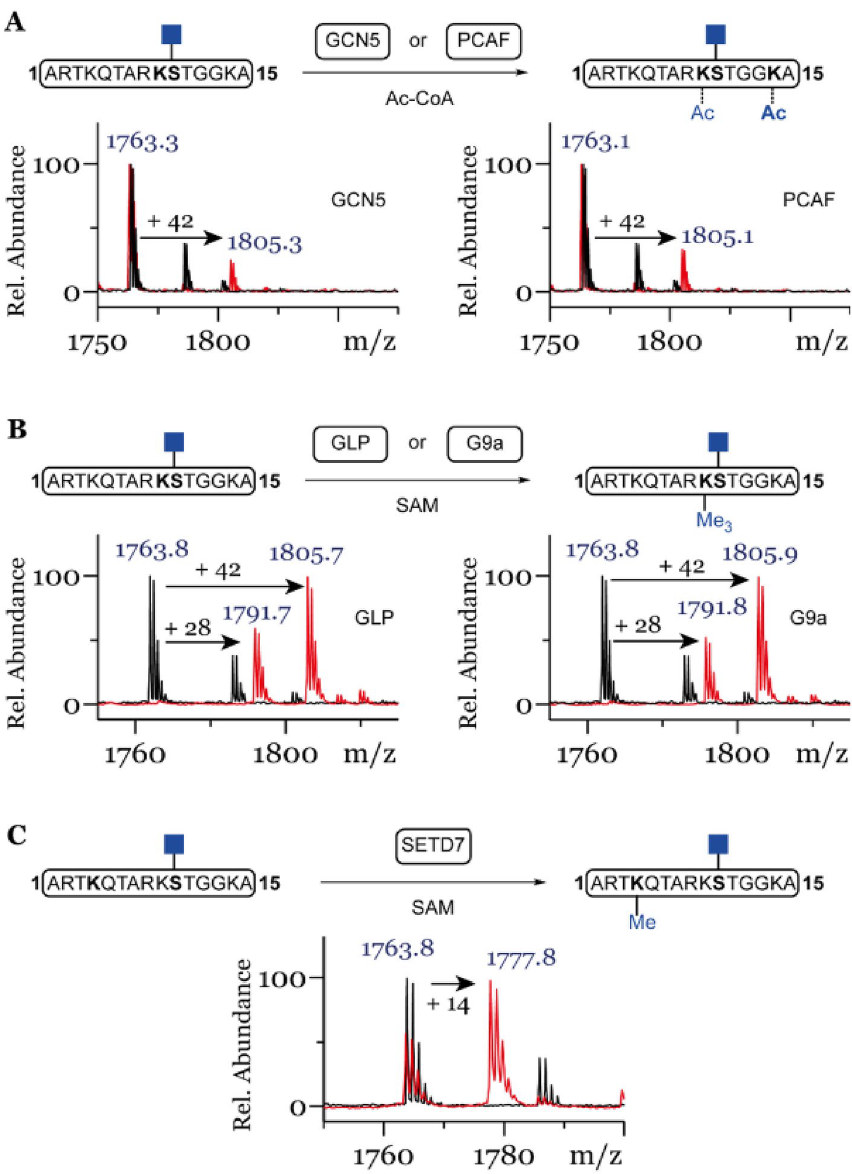
Figure 4. ( A ) Mono-acetylation of H3S10ßGlcNac by lysine acetyltransferases GCN5 or PCAF, ( B ) Di- and tri-methylation of H3S10ßGlcNac by lysine methyltransferases GLP or G9a, ( C ) Mono-methylation of H3S10ßGlcNac by lysine methyltransferase SETD7. Red spectra show 3 h reactions at 37 °C with KATs (2 uM), histone peptide (100 µM) and Ac-CoA (300 µM) ( A ) or 1 h incubations with KMTs (2 µM), SAM (500 µM for GLP/G9a and 200 µM for SETD7) ( B , C ) of histone peptide 15 (100 µM) and black spectra the no-enzyme